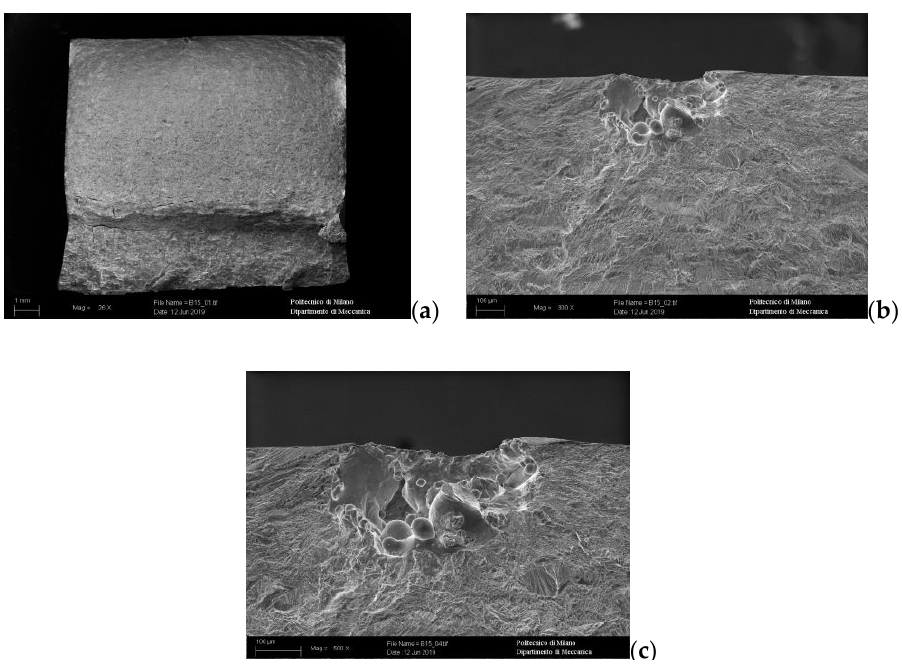
Figure 12. Tooth B15—the nucleation zone is remarked in ( a ), where large fusion defect (about 240 μm deep) with unmelted particles is clearly visible on the outer surface ( b and c ).